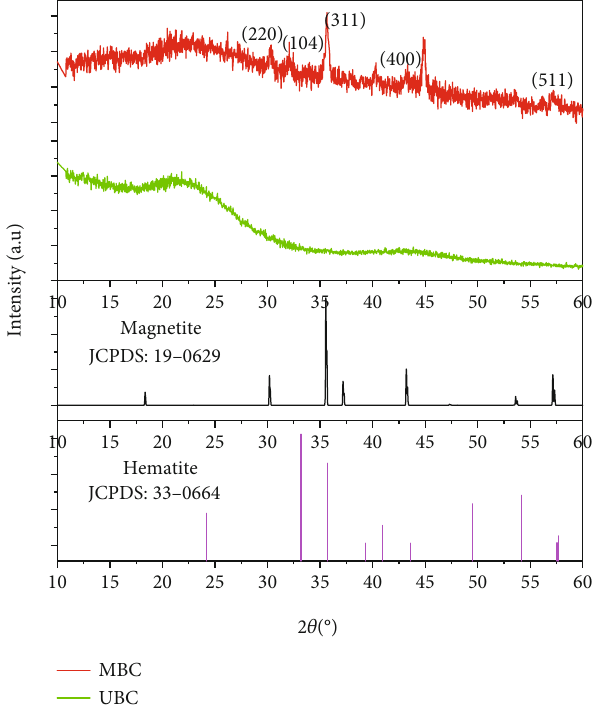
Figure 2: XRD patterns of raw and modi fi ed